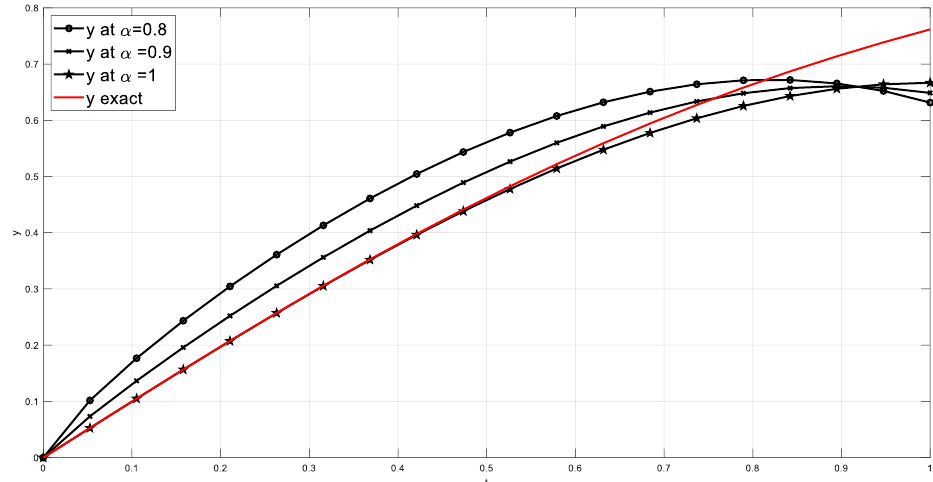
Figure 2. Approximate and exact solutions of Equation (24). Table 3. Values of the approximate and exact solutions of Equation (26) at different values of 𝓉 . Table 4. Values of the approximate and exact solutions of Equation (28) at different values of 𝓉 .